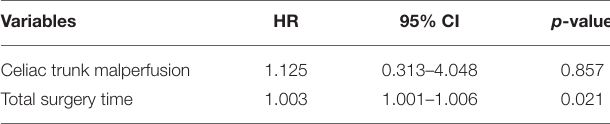
TABLE 4 | The multivariable Cox proportional hazards analysis for midterm